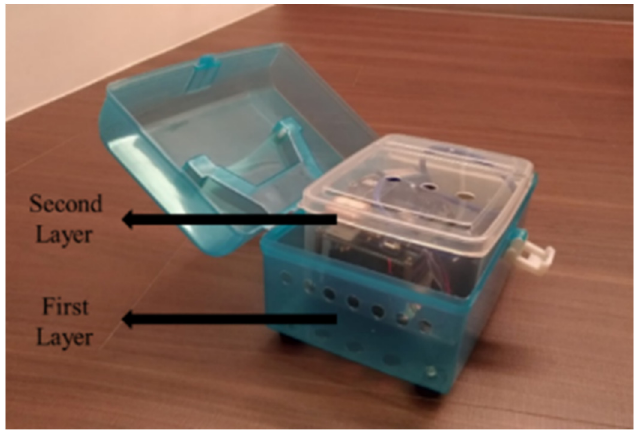
Figure 3. Waterproof double layer case.